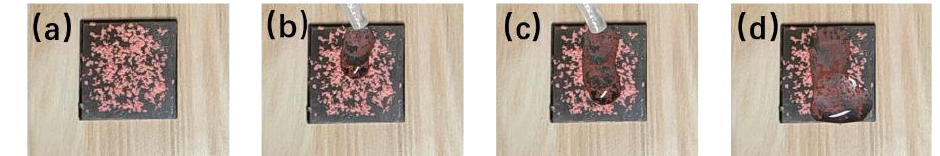
Figure 12. Cleaning process of Q235 steel surface: (a) chalk dust was spread on the surface of Q235 steel surface, ( b ) water drops on the surface of Q235 steel, ( c ) water flowing over the surface of Q235 steel sprinkled with chalk dust, and ( d ) large amount of chalk dust still on the surface of Q235 steel.